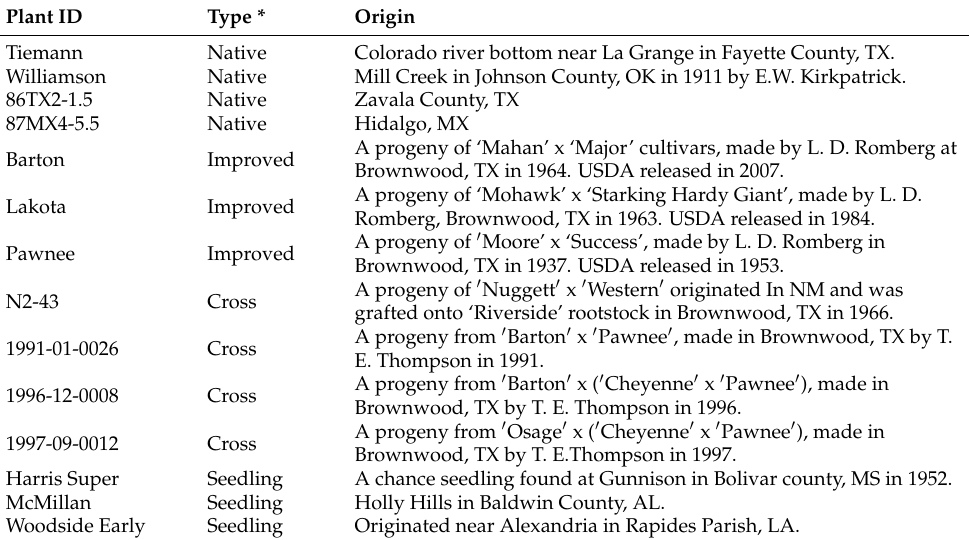
Table 5. Pecan sample information, including tree origination and background